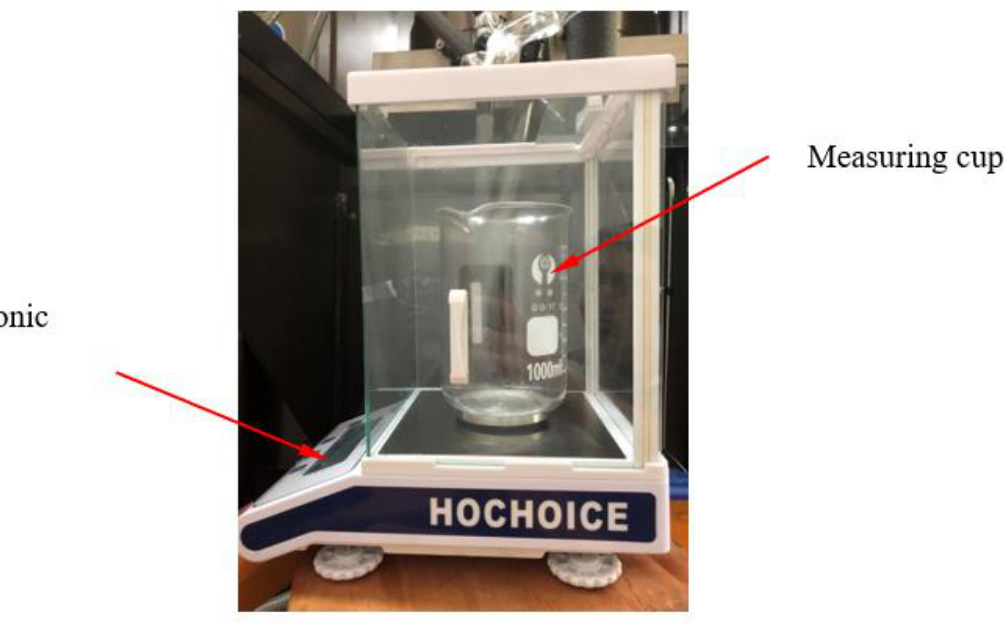
Figure 4. Outlet water collection device.